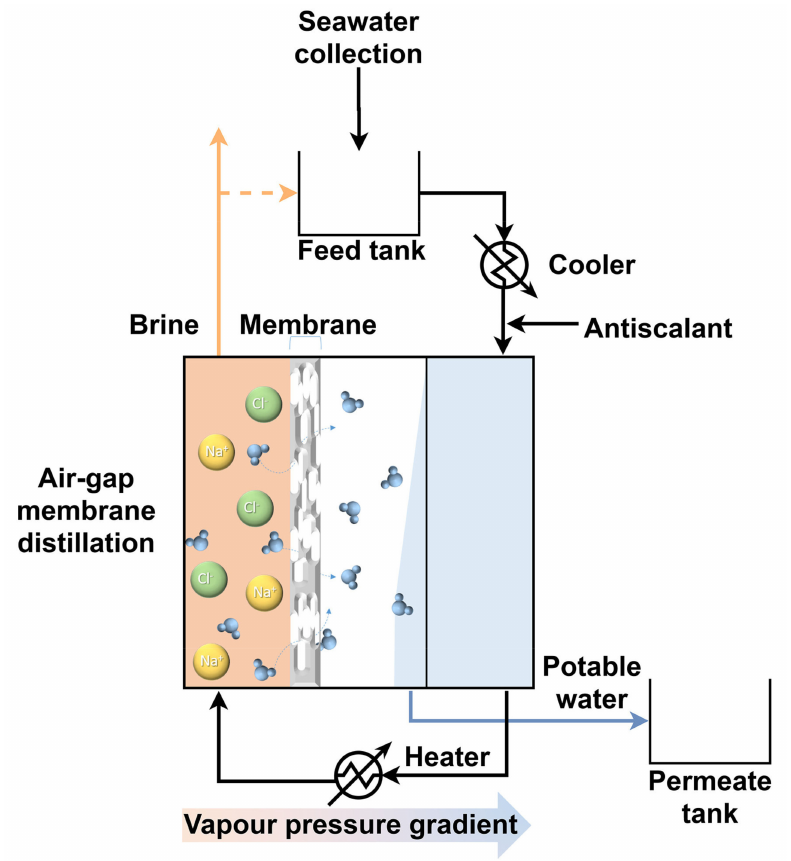
Figure 1. Membrane distillation operation with an air-gap configuration. Reprinted from Ref.